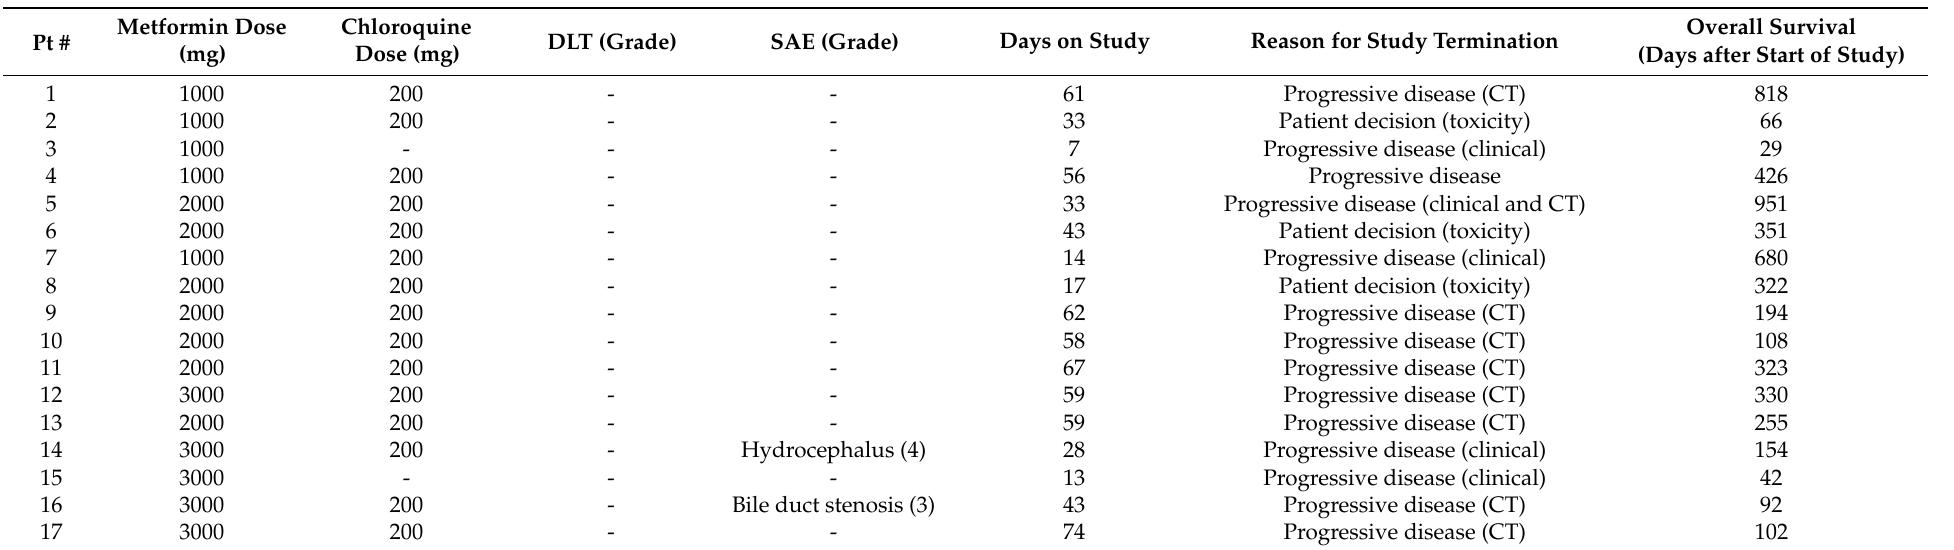
Table 3. Description of administered doses, dose-limiting toxicities and serious adverse